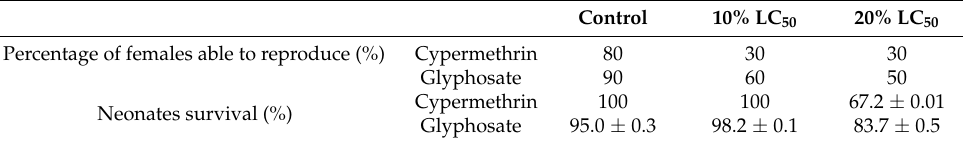
Table 1. Parthenogenetic reproduction and neonate survival of Eucypris sp. exposed to low concen- trations of cypermethrin and glyphosate. Survival of neonates is presented as average ± standard